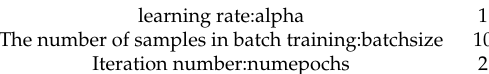
Table 5. Training parameter